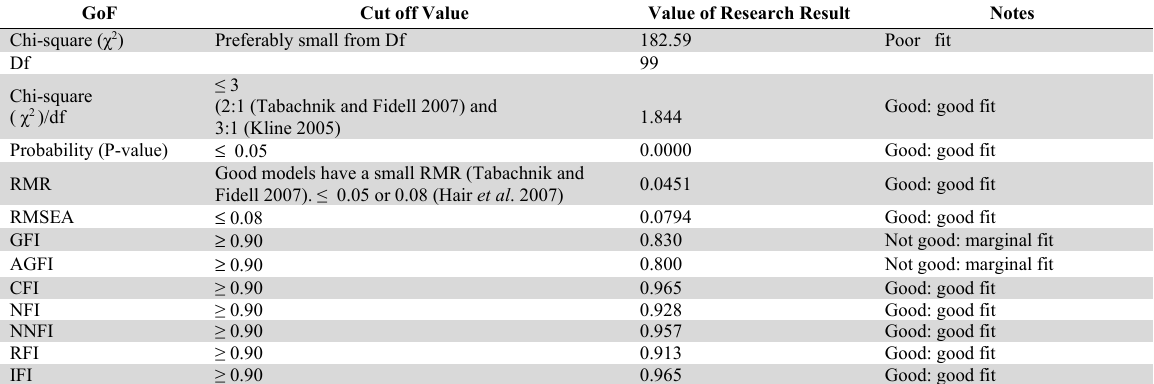
Results of the Overall Fit Criteria